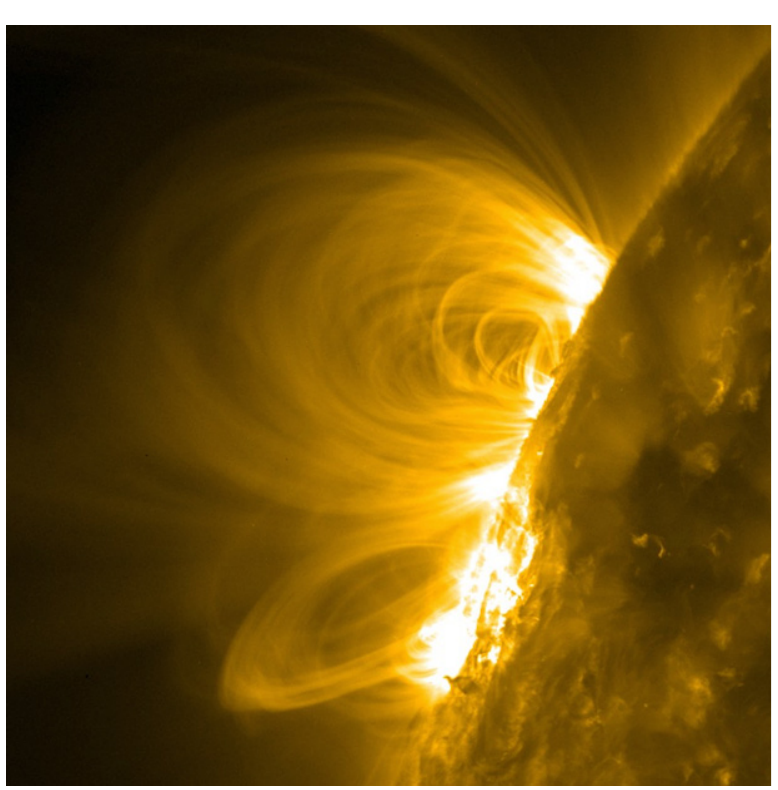
Figure 3: Coronal loops have approximately a semicircular shape. Image: SDO/AIA, 171 ˚A filter, 24 February 2011. Credit: